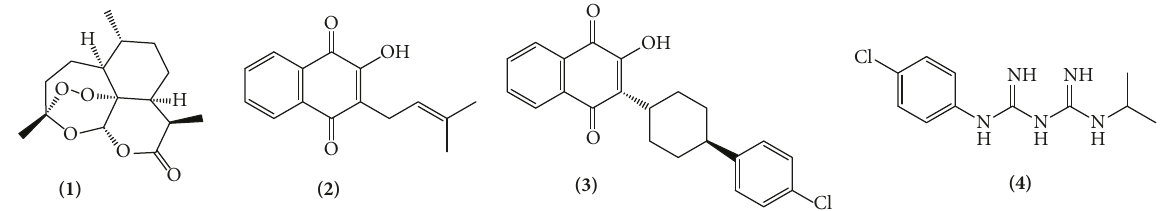
Figure 1: Chemical structures of artemisinin ( 1 ), lapachol ( 2 ), atovaquone ( 3 ), and proguanil ( 4 ).